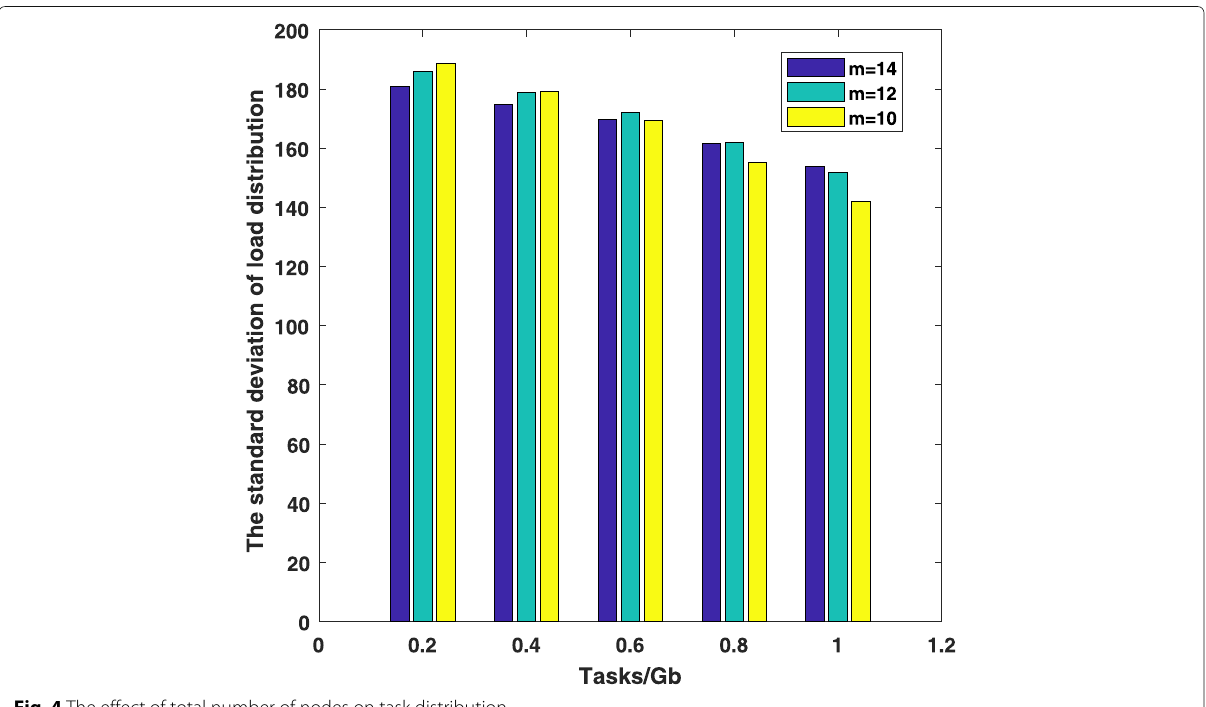
Fig. 4 The effect of total number of nodes on task distribution